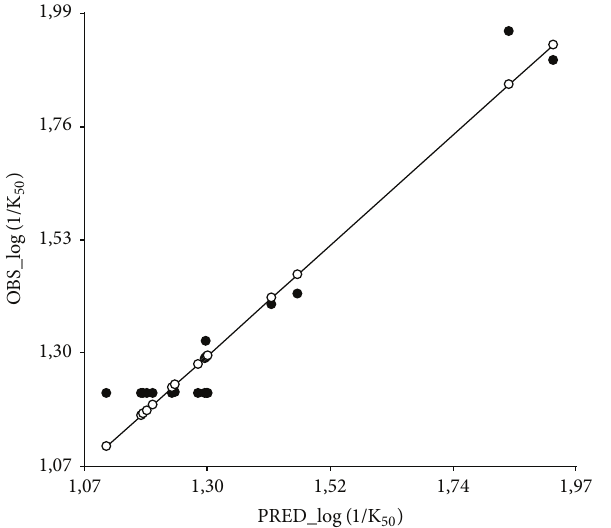
Figure 2: Multiple linear regression analysis (MLR) calculated to examine quantitative relationships between linear combinations of the dependent variable log (1/KT 50 ) and the predictor variables (structure and molecular properties). Plot of calculated versus experimental log (1/KT 50 ) of fumigant activity of oxygenated and hydrocarbon terpenes against lice.